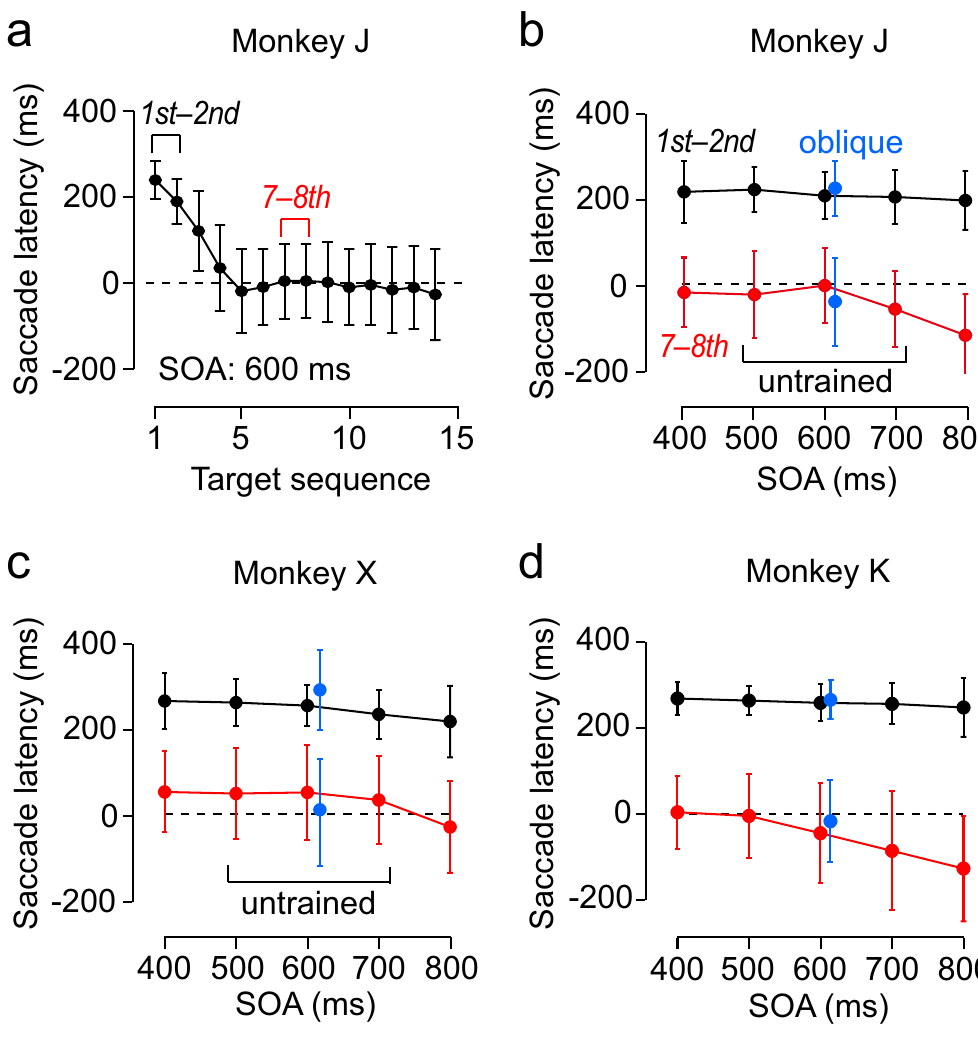
Figure 3. Generalization of predictive synchronization to novel SOAs and target locations. ( a ) Mean saccade latency in the predictive condition as a function of target sequence in monkey J. Each data point represents the mean of 409 saccades from five experimental sessions and the error bar indicates trial-by-trial variation ( ± SD). ( b ) Mean saccade latencies for different SOAs in monkey J. Although the animal was trained only for shorter and longer SOAs (300, 400, 800 and 900 ms), he could make synchronized saccades for novel SOAs of 500–700 ms. Generalization also occurred for oblique targets (blue symbols). Error bars indicate ± SD of individual trials pooled across 5 experiments. Each data point denotes the mean of 732–818 saccades. ( c , d ) Data from two other monkeys. Note that monkey K had been trained for all SOAs and target locations, but monkey X had never been presented with SOAs of 500–700 ms or oblique targets before the test sessions. Corresponding circular histograms are shown in Supplementary Fig. S1. Data from 5 individual sessions in monkeys J and X are shown in Supplementary Fig.